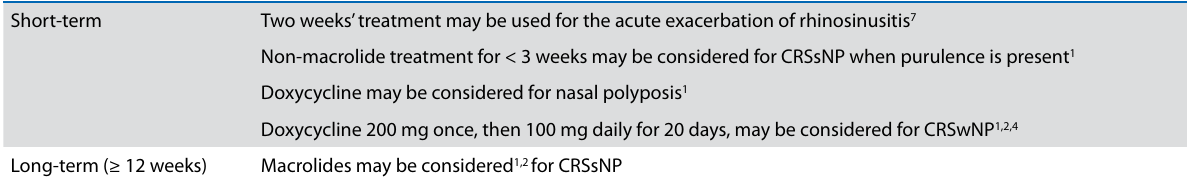
Non-macrolide antibiotics